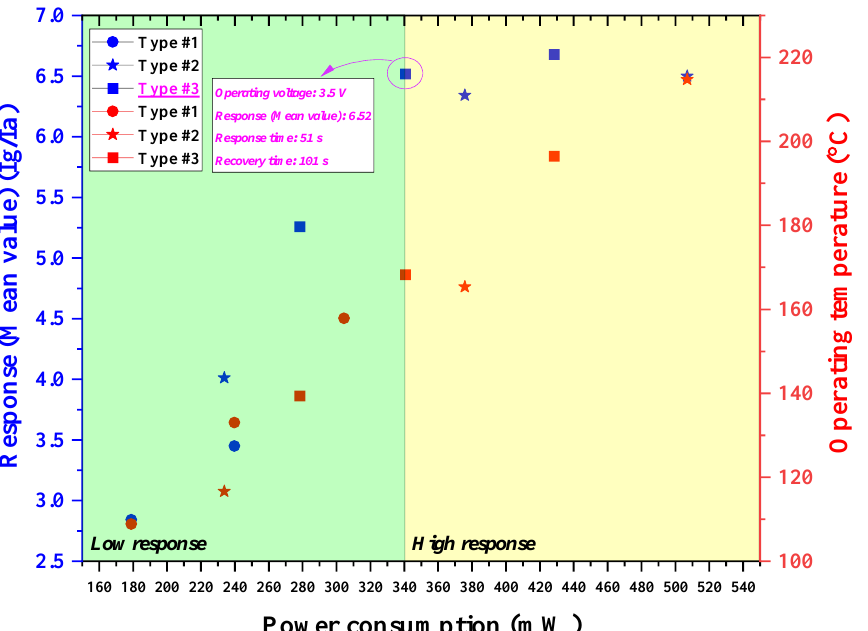
mance (response: 6.52, response time: 51 s, recovery time: 101 s) for portable gas sensor